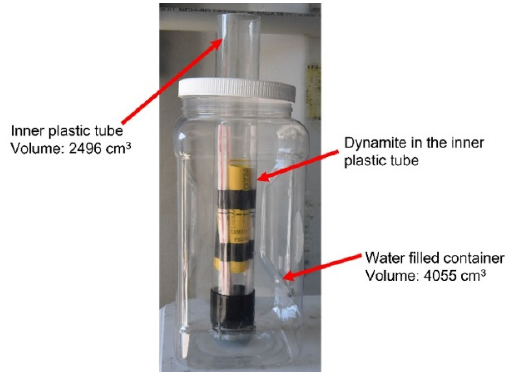
Figure 1. Experimental test set ‐ up in an underground limestone test arena. Figure 2. The half water ‐ cased charge showing the locations of the dynamite and inner plastic tube.